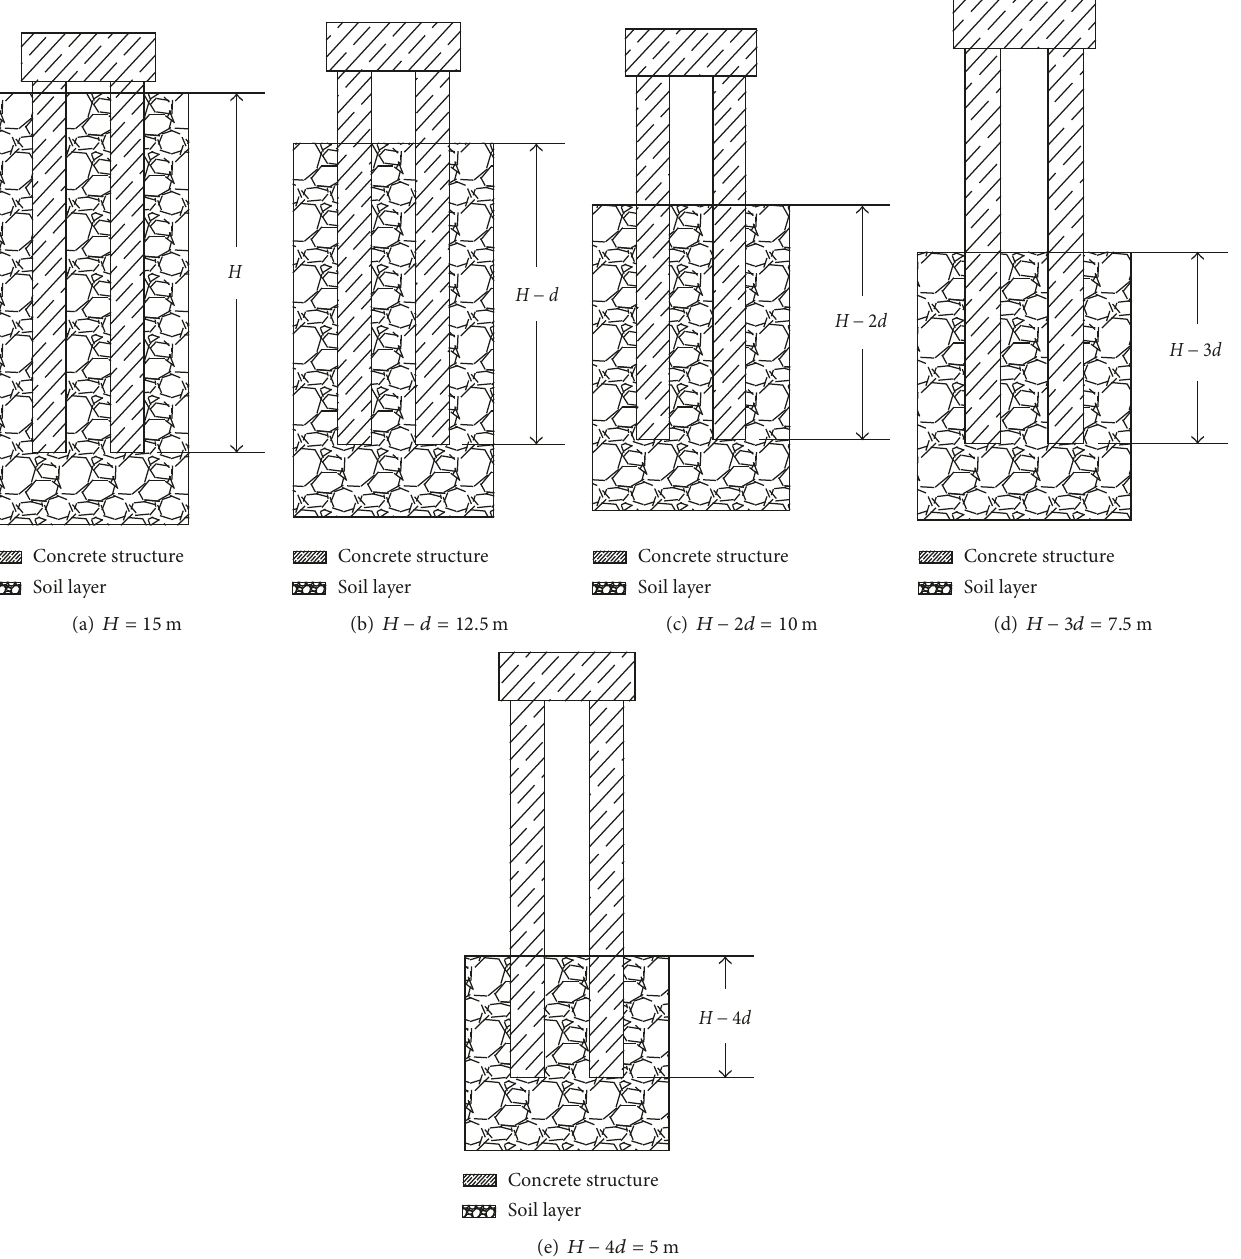
Figure 8: Sketch of decrease of the effective friction area between piles and soil. The embedded depth of piles was designed as (a) 𝐻 , (b) 𝐻 − 𝑑 , (c) 𝐻 − 2𝑑 (d) 𝐻 − 3𝑑 , and (e) 𝐻 − 4𝑑